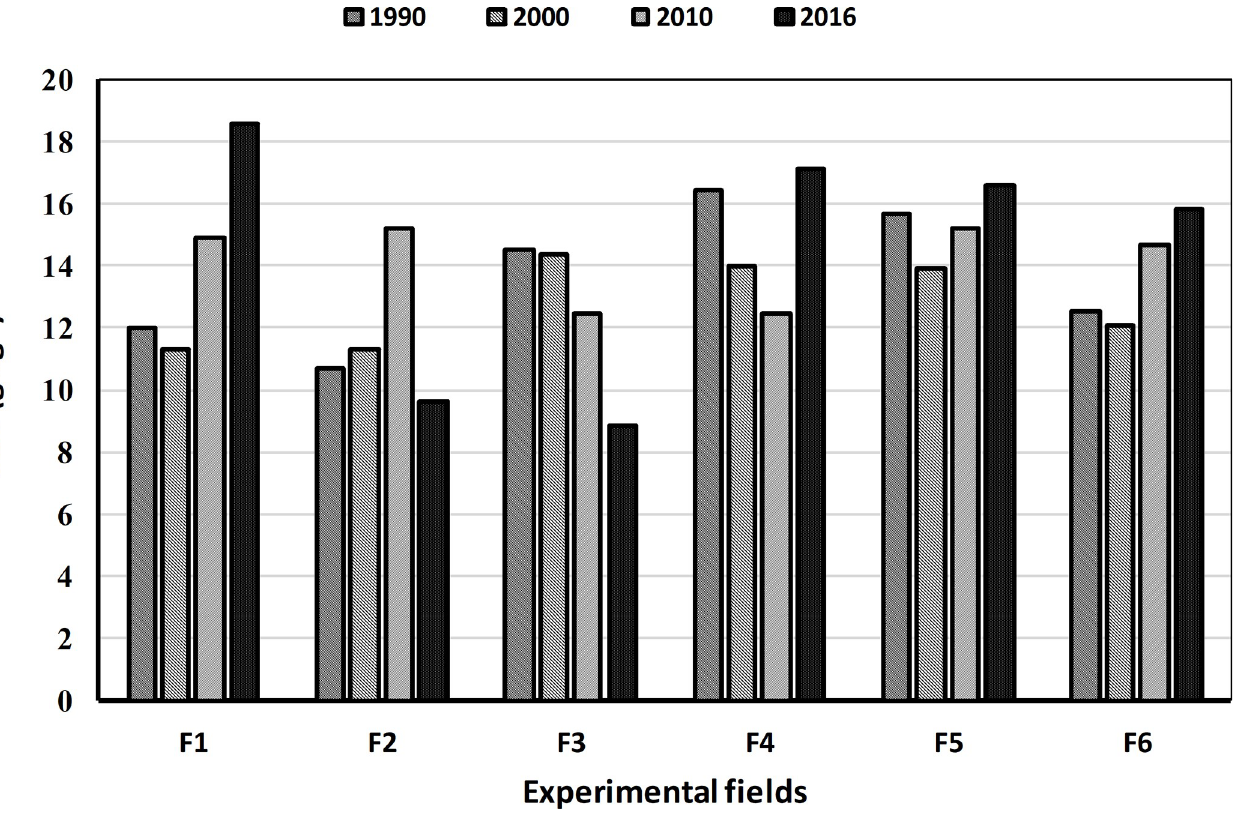
Fig 3. Mean values of the SOC content of the experimental fields during the study